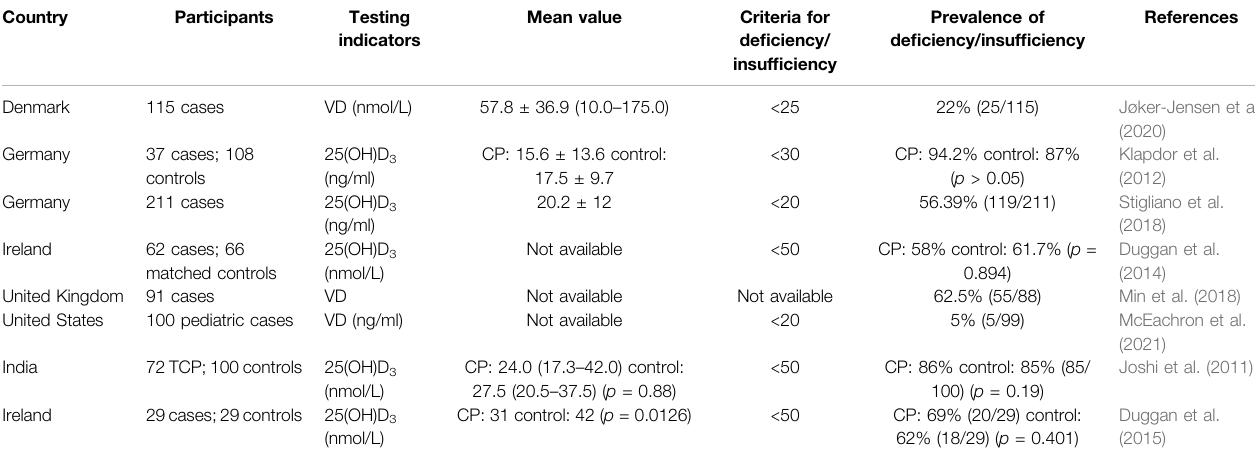
TABLE 1 | Overview of reports on vitamin D (VD) de fi ciency/insuf fi ciency in